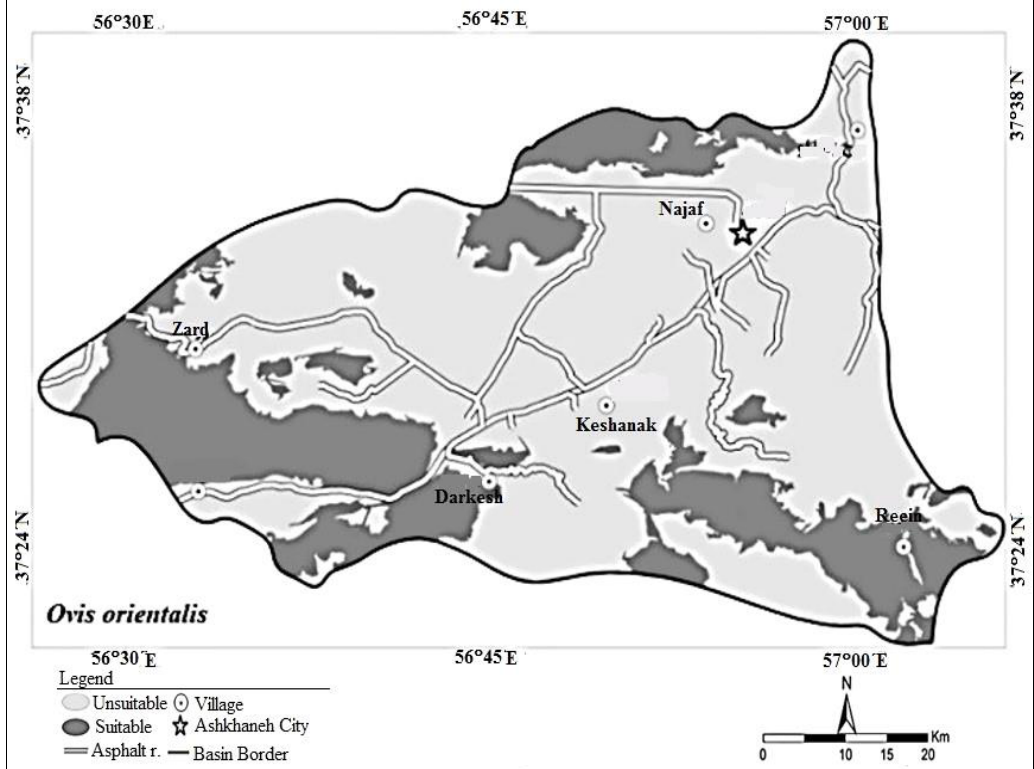
Figure 5. The habitat classification